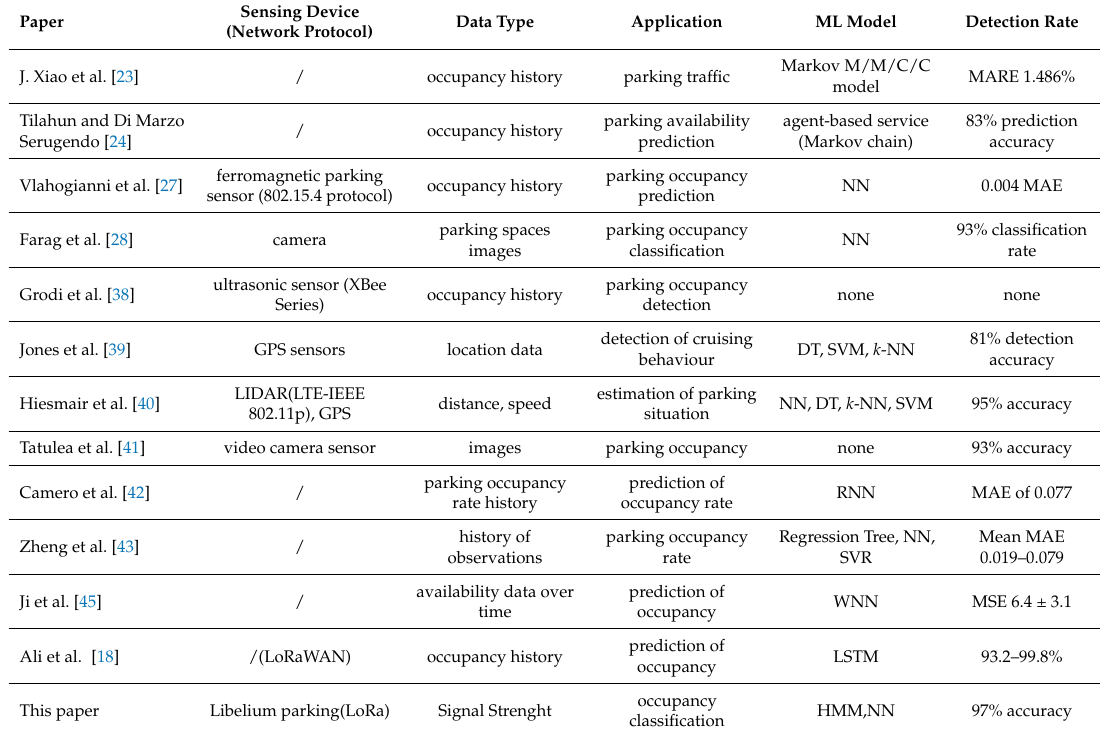
Table 1. Comparison table of various sensing technologies and it applications in Smart